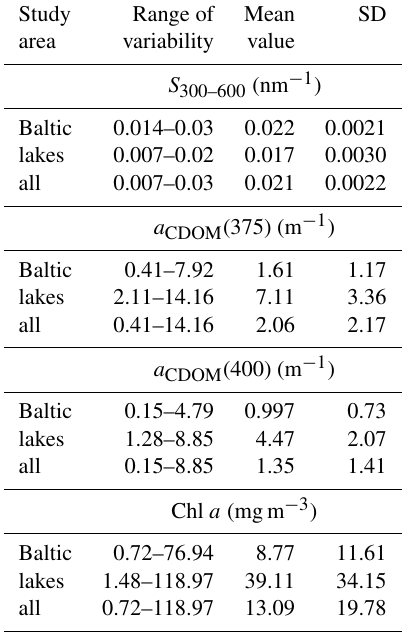
Table 2. Range of variability of the spectral slope S 300–600 , co- efficients of light absorption by CDOM for wavelengths λ = 375 and 400nm ( a CDOM (375) and a CDOM (400)), and concentrations of chlorophyll a (Chl a ), calculated for the empirical data.